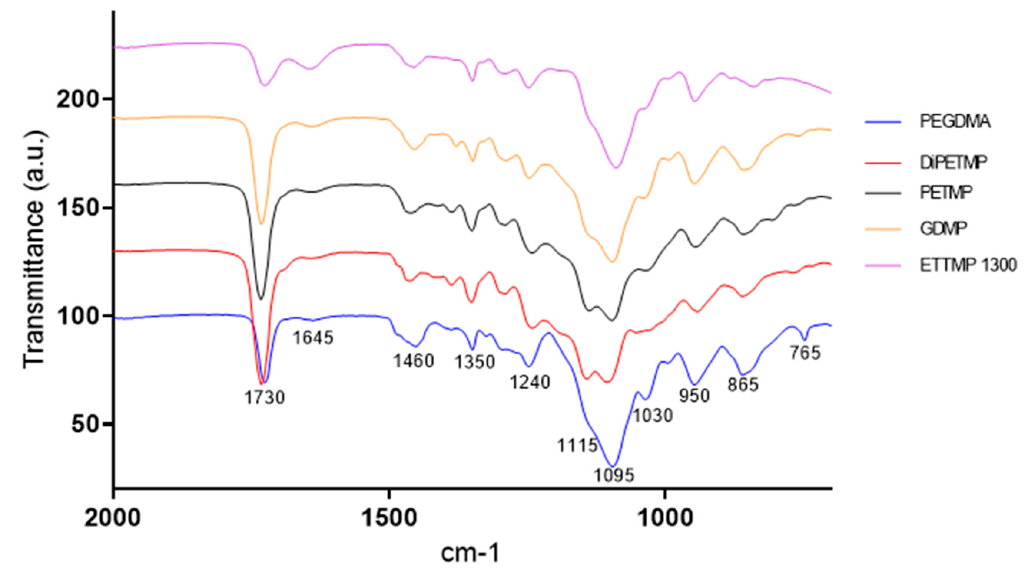
Figure 3. The FTIR spectra for PEGDMA and PEGDMA-thiol samples post polymerization.